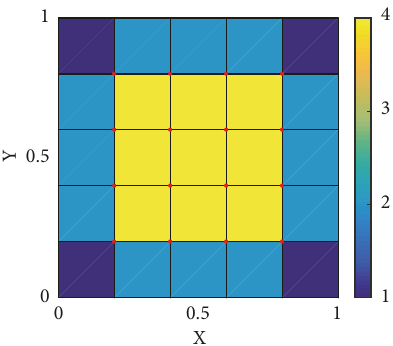
Figure 14: Finite element mesh for the example in Section 4.4. All the internal nodes have been enriched.